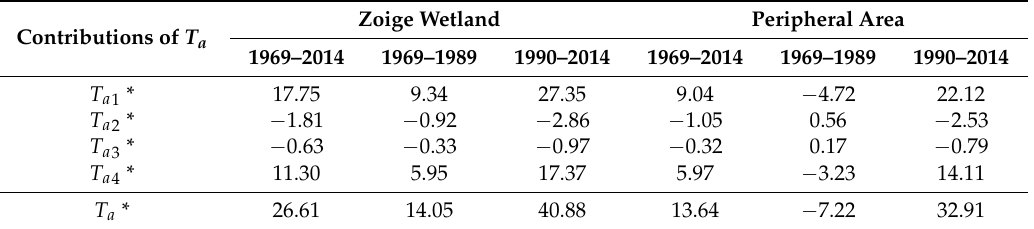
Table 6. Contributions of temperature ( T a ) on annual E pan via changes in net radiation ( R n ) and